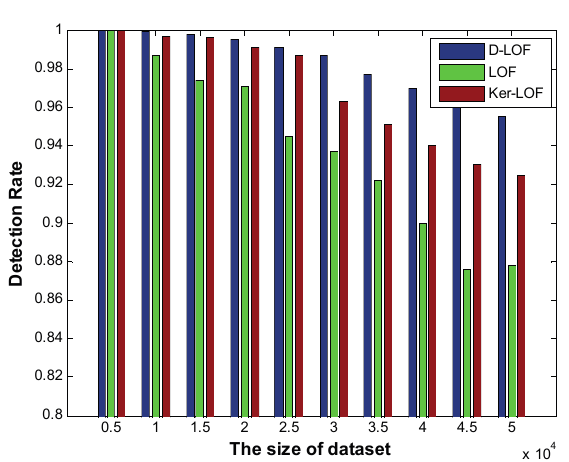
Figure 5. Run time with different k.